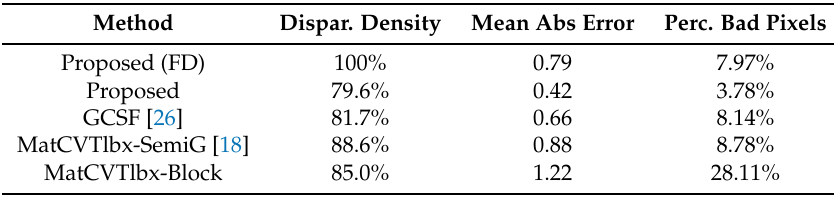
Table 5. Comparative results for the “Dimitris-Chessboard” sequence.